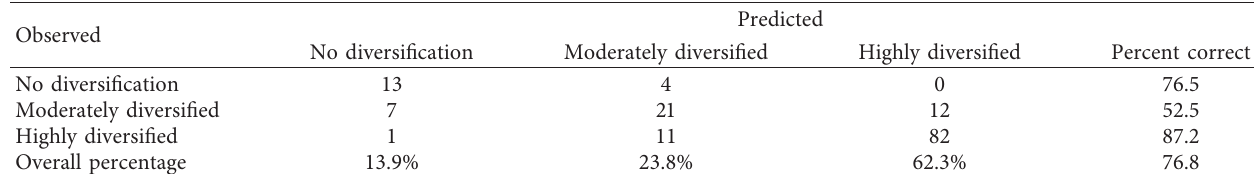
Table 3: Classification table of the multinomial logistic regression